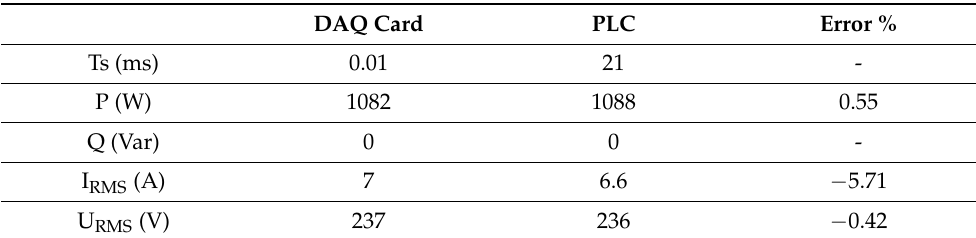
Table 5. Values obtained with DAQ card and PLC